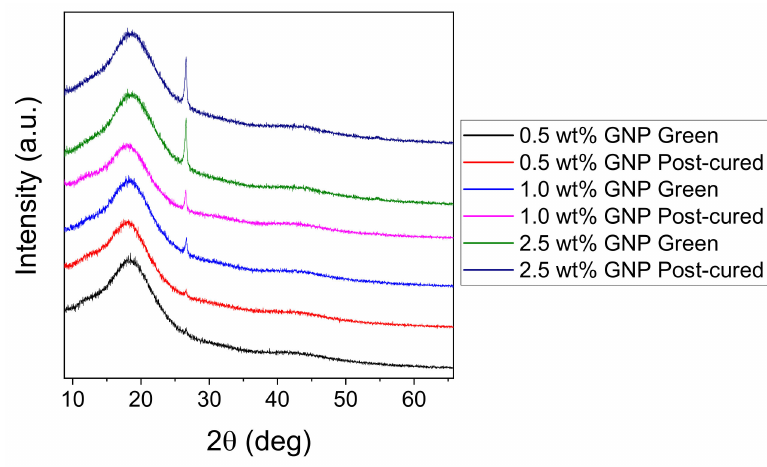
Figure 2. XRD characteristic curves of green and post-cured nanocomposites containing 0–2.5 wt %